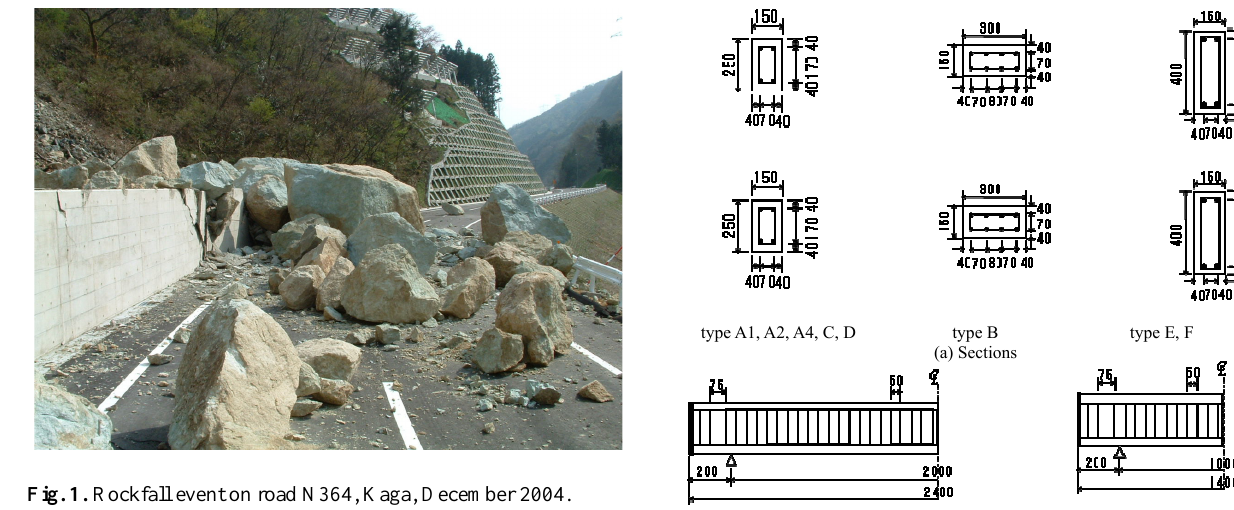
Figure 1. Rockfall event on road N364, Kaga, Dec. 2004 Fig. 1. Rockfall event on road N364, Kaga, December 2004.